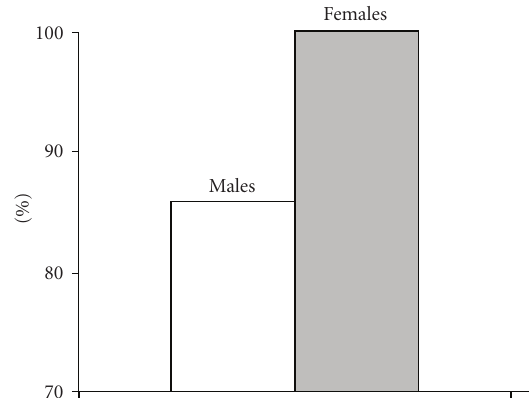
Figure 1: Prevalence (%) of osteoporosis osteopenia syndrome in hypogonadal male and female patients with TM.